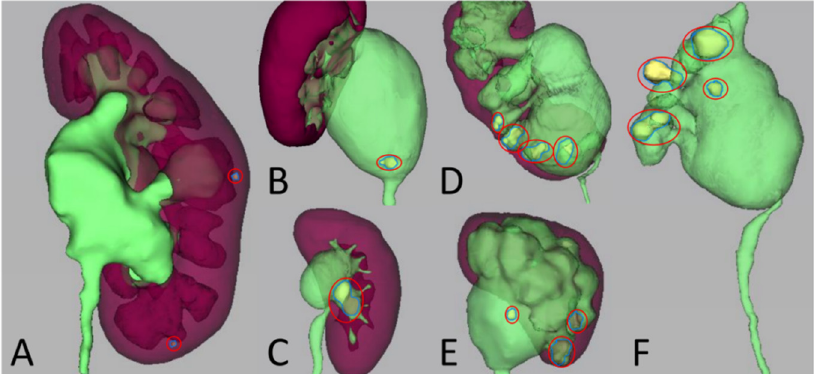
Figure 2. 3D CT reconstruction models of renal calculi and adjacent structures such as renal parenchyma, renal pelvis and calyces in different patients. ( A ) stone located in the deep part of renal calyces; ( B ) stone located above the ureteropelvic junction; ( C ) stone located at the openings of multiple renal calyces; ( D ) multiple stones located in different renal calyces; ( E ) multiple stones located in the deep part of renal pelvis and calyces; ( F ) large multiple stones located in the deep part of renal pelvis and multiple renal calyces. (Renal calculi were indicated by red circles.)